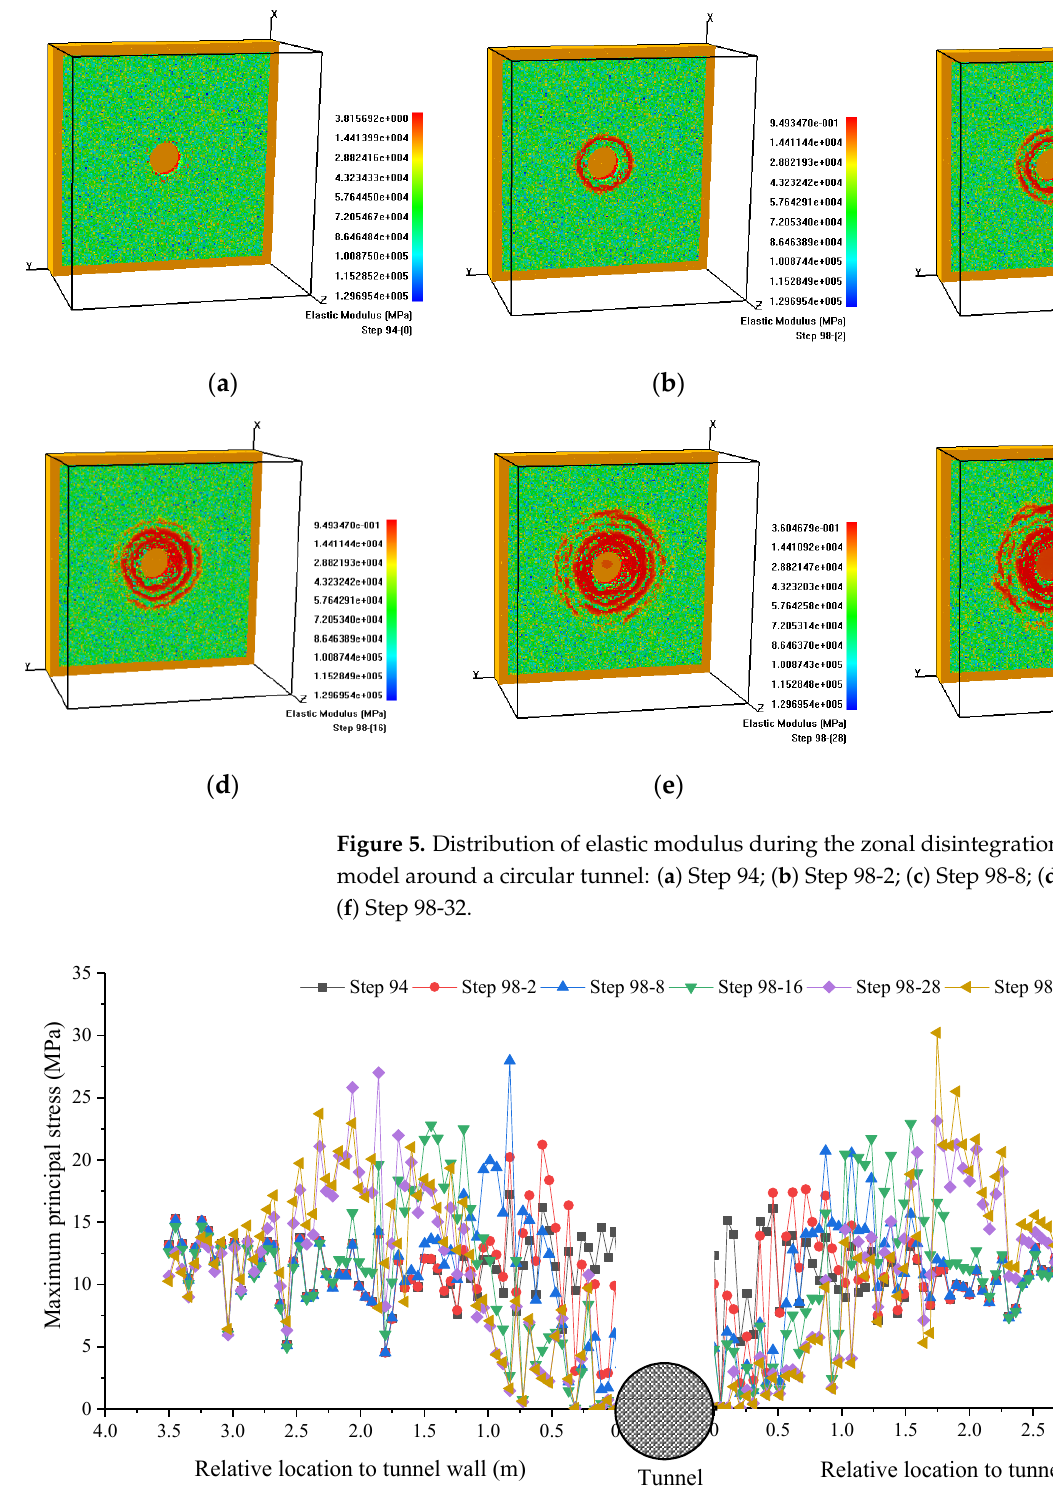
Figure 6. The maximum principal stress-transfer process of surrounding rock during zonal disinte- gration formation of Model A.